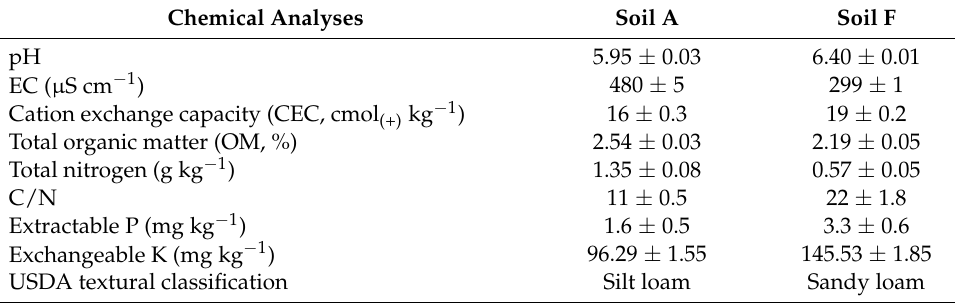
Table 2. Selected chemical properties of A and F soils (mean values ± SE).